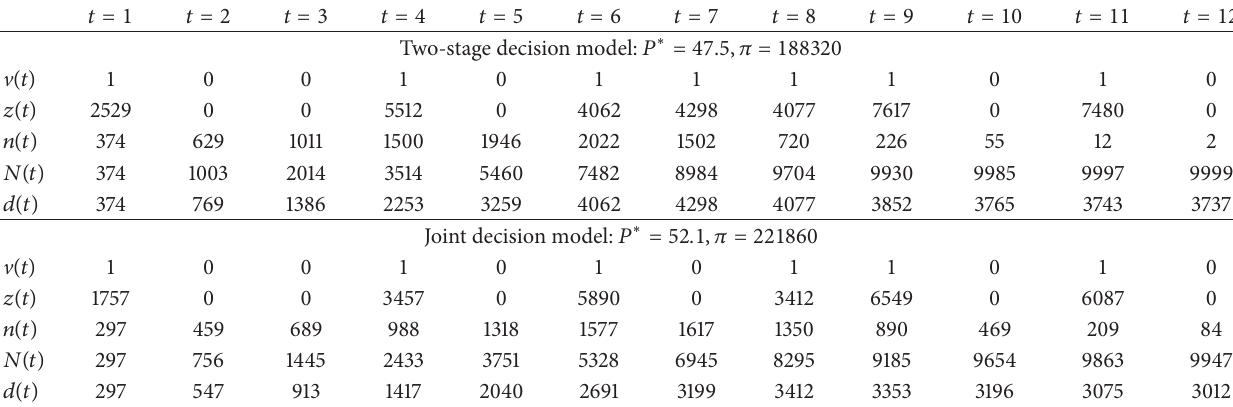
Table 1: Comparison of the optimal pricing and ordering decisions.